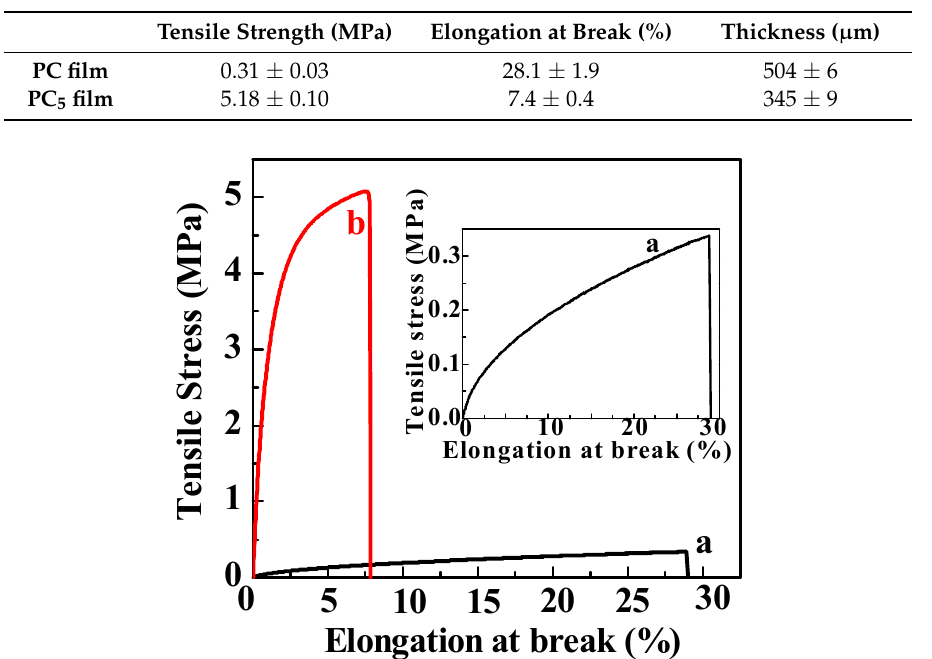
Figure 9. Typical stress—strain curves of PC (a) and PC 5 (b) films.